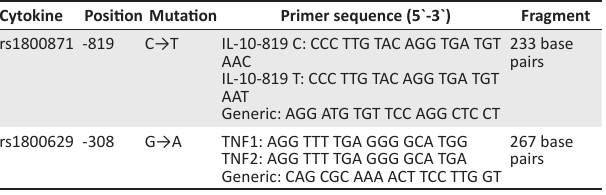
TABLE 1: Primers used in detecting TNF- α (rs18006290) and IL-10-819 T>C (rs1800871) polymorphisms among S. haematobium infected and uninfected preschool children from Shamva district, Mashonaland Central province, Zimbabwe, September 2018. Cytokine Position Mutation